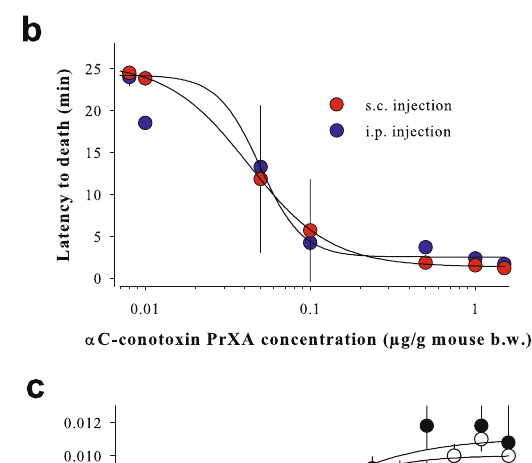
3 Scientific RepoRts | 7: 7202 | DOI:10.1038/s41598-017-07554-5